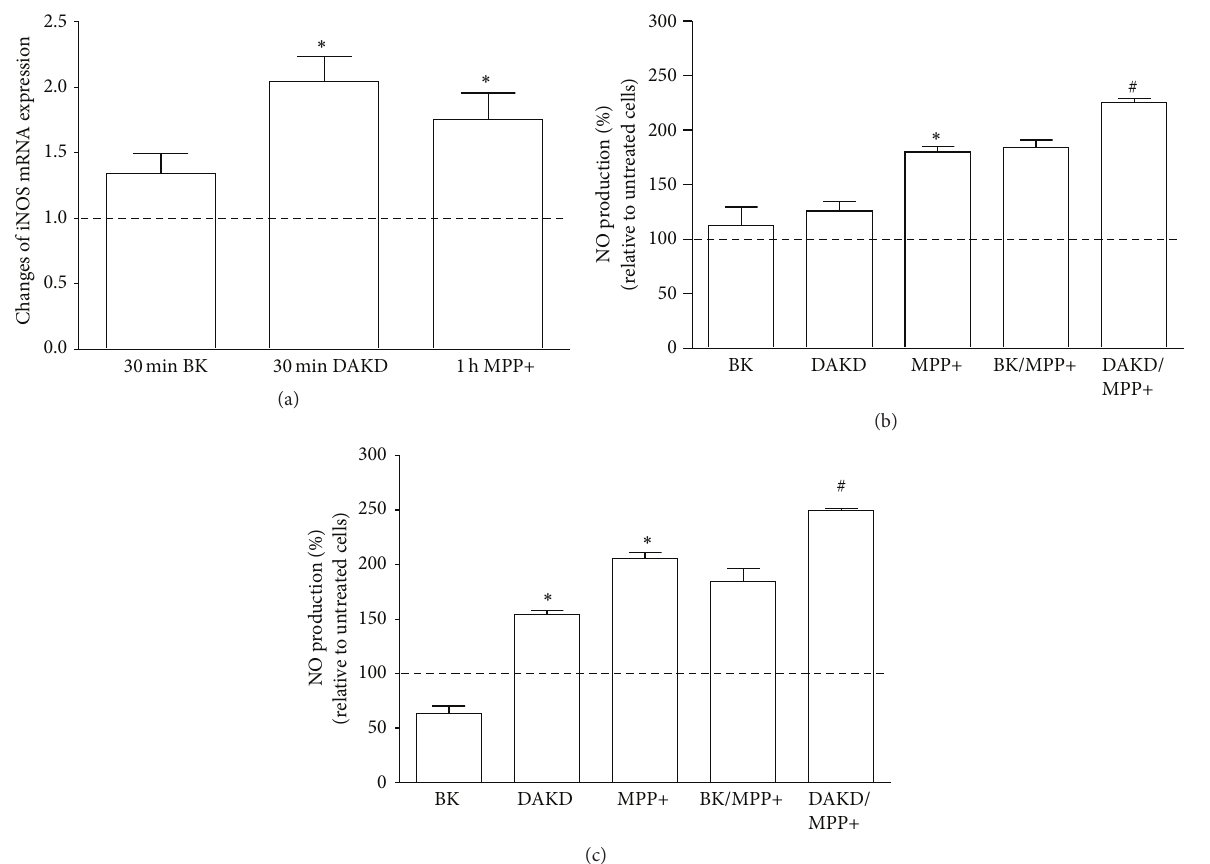
Figure 3: The induction of iNOS mRNA expression and NO production in differentiated SK-N-SH cells by kinin peptides. Confluent cells were treated with 1 𝜇 M BK, 1 𝜇 M DAKD, or 5 mM MPP+ for different time intervals as described in Materials and Methods and iNOS mRNA expression was analyzed by Real-Time PCR (a). The NO released by confluent cells after treatment with kinin peptides without or in the presence of 2.5 mM MPP+ was analyzed with fluorometric assay, as described in Materials and Methods after 15-minute (b) or 30-minute incubation (c). The bars represent the mean percentage of the changes in comparison to untreated cells, assumed to show values equal to 100% (dashed line). At least three experiments were performed in triplicate. ∗ 𝑃 < 0.05 versus untreated cells; # 𝑃 < 0.05 versus MPP+-stimulated